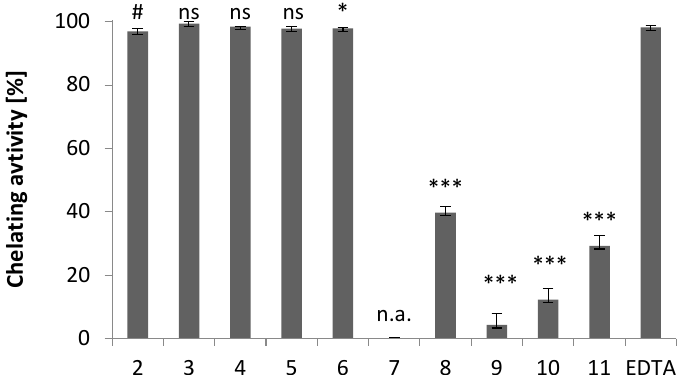
Figure 7. Ferrous ion chelating activity of iron ions of compounds 2 – 11 and the standard chelating agent EDTA. The results ( n = 3) are presented as the mean value ± standard deviation (* p < 0.05, *** p < 0.001) in comparison with EDTA. Non statistically significant difference ( p > 0.05) is indicated as ns. Inactive compounds are indicated as n.a. # Data published in [18].